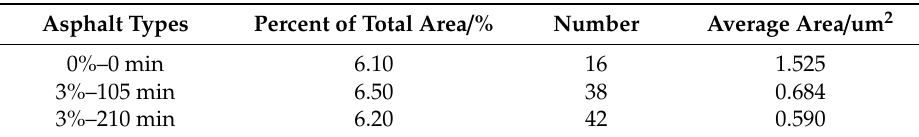
Figure 8. Image post-processing of the bee structure by Image-pro Plus (3% – 105 min). Table 3. Parameters of the bee structure.